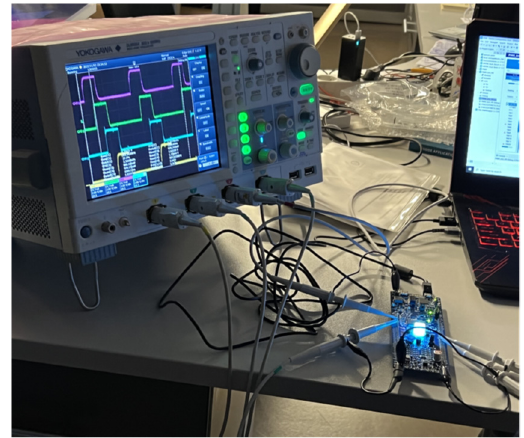
Figure 34. Interleaved PWM signals generated by STM32G474RET6 microcontroller.